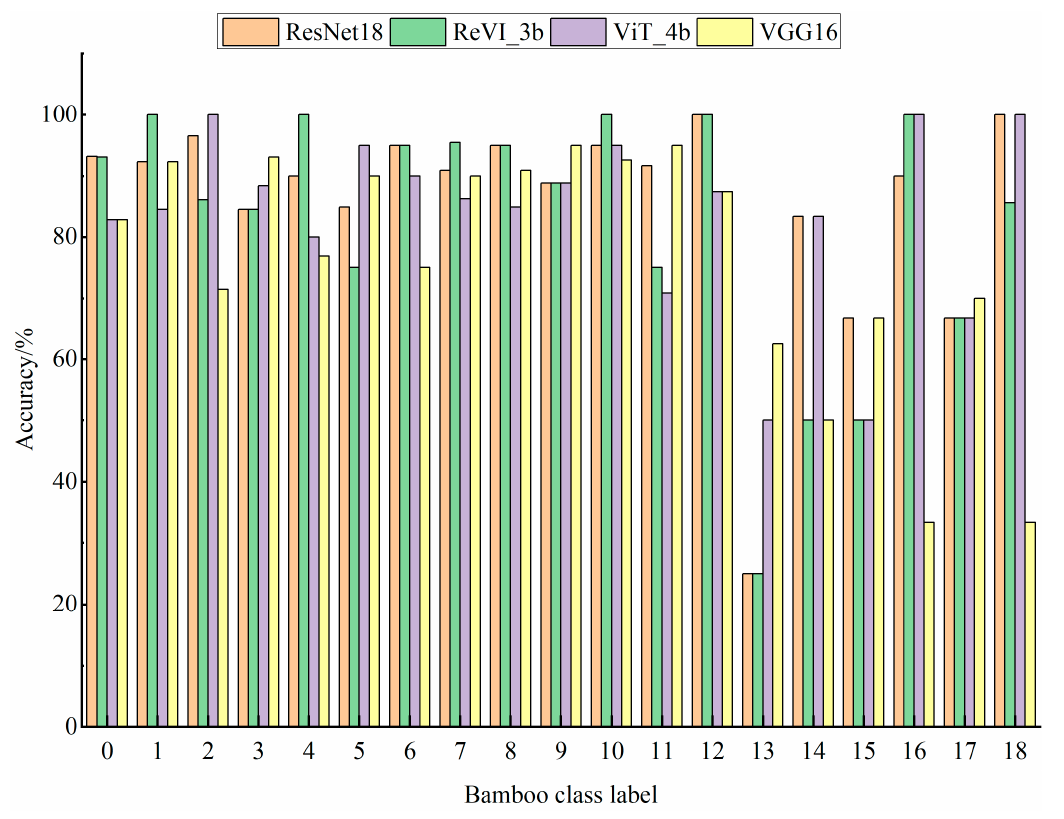
Figure 13. Classification results of different models for each class of bamboo.